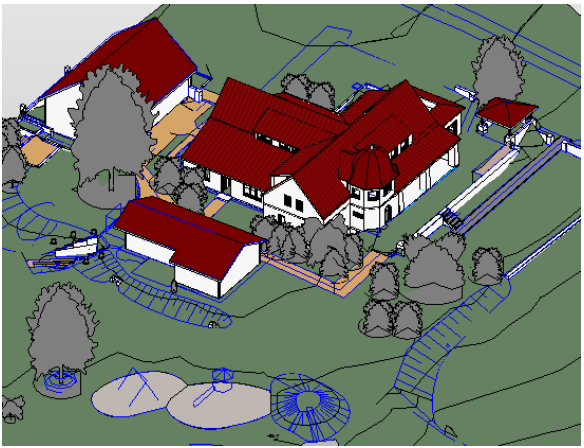
Figure 7 Result of BIM-able landscape